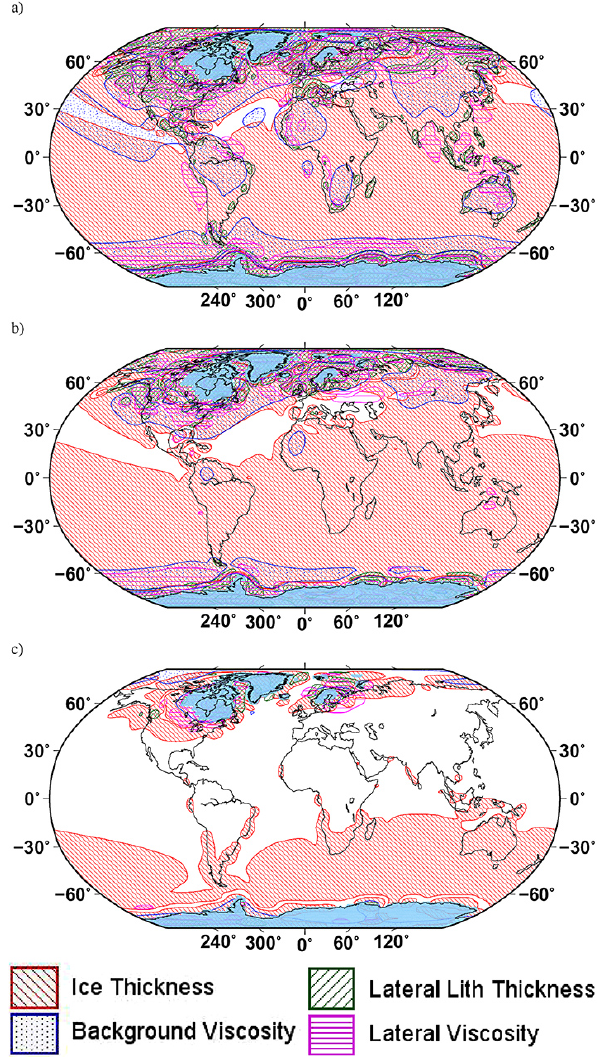
Figure 8. Same as Fig. 5, but for 10ka and different RSL data errors of (a) 1, (b) 2 and (c)